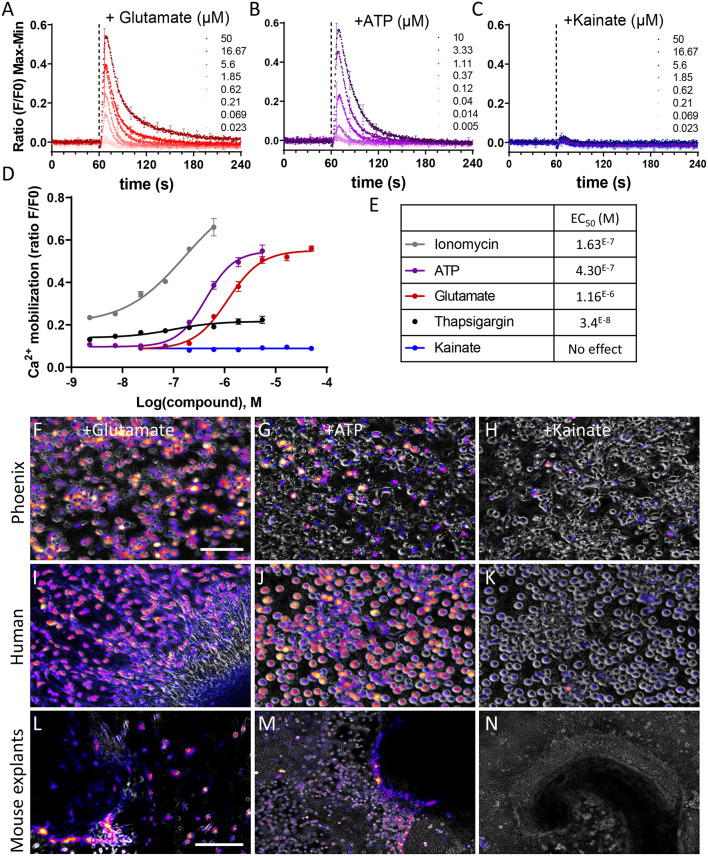
Phoenix and human fetal auditory neurons exhibit glutamatergic and purinergic Ca2+ transients. (A–C) Kinetics of Ca2+ transients induced by (A) glutamate, (B) ATP, (C) kainate in phoenix auditory neurons after 7 days of differentiation. Phoenix auditory neurons were loaded with Ca2+-sensitive ratiometric probe (FLUO-8) and stimulated with increasing concentrations of glutamate (0.02–50 μM), ATP (0.005–10 μM), or kainate (0.02–50 μM). (D) Dose–response curves were extracted from the max–min amplitude values, allowing the determination of an EC50 value (E) Ionomycin and thapsigargin were used as positive control. Data represent the average ± SEM of three independent experiments. (F–N) Live Ca2+ imaging of (F–H) phoenix auditory neurons, (I–K) human sphere-derived auditory neurons, and (L–N) mouse cochlear explants following stimulation with 100 μM glutamate (F,I,L), ATP (G,J,M), or kainate (H,K,N). The magenta color represents cells where Ca2+ mobilization was induced. (F–K) Scale bar: 100 μm; (L–N) scale bar: 500 μm. Data are representative of three independent experiments.